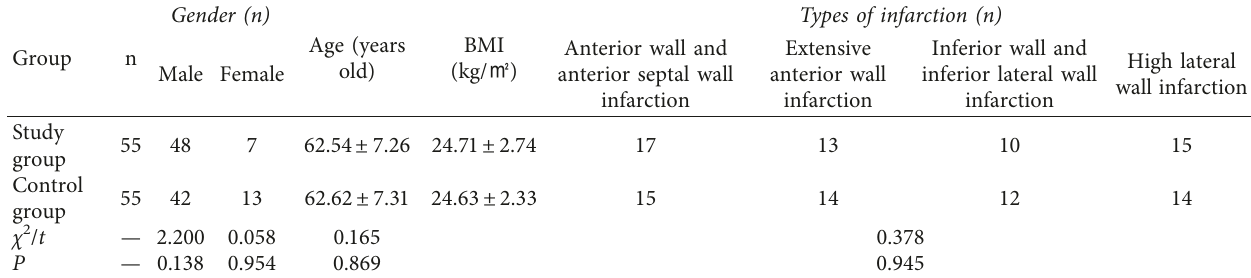
Table 1: Comparison of general data of patients between the two